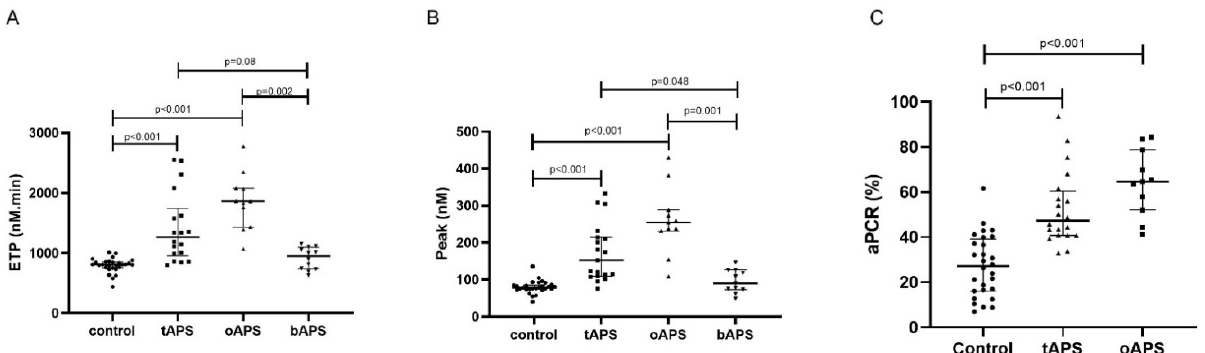
Figure 1. Thrombin generation profiles in antiphospholipid syndrome patients. ( A ) Endogenous thrombin potential. ( B ) Thrombin peak. ( C ) Activated protein C resistance. Kruskall − Wallis and Dunn’s multiple comparison test were used. tAPS: thrombotic antiphospholipid syndrome. oAPS: obstetrical antiphospholipid syndrome. bAPS: biological antiphospholipid syndrome. Circle is for control. Square is for thrombotic antiphospholipid syndrome in figure A et B, and obstetrical antiphospholipid for C. Triangle is for obstetrical antiphospholipid syndrome in figure A et B, and thrombotic antiphospholipid for C. tAPS and oAPS are described in legend.